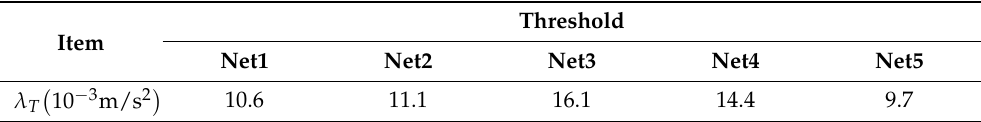
Table 1. The first threshold of Net1~Net5.